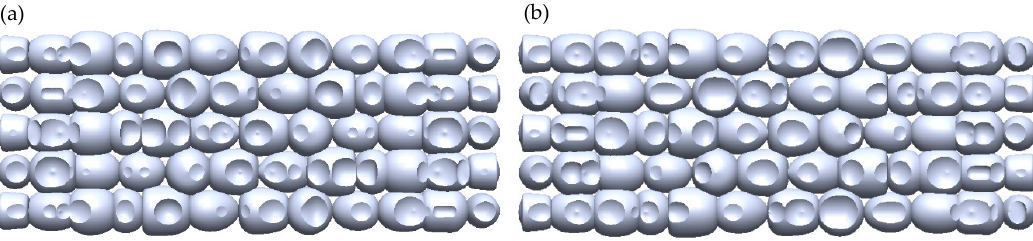
Figure 2. ( a ) The side view of the jointing element between assemblies one and two, as well as assemblies three and four; ( b ) The side view of the jointing element between assemblies two and three.